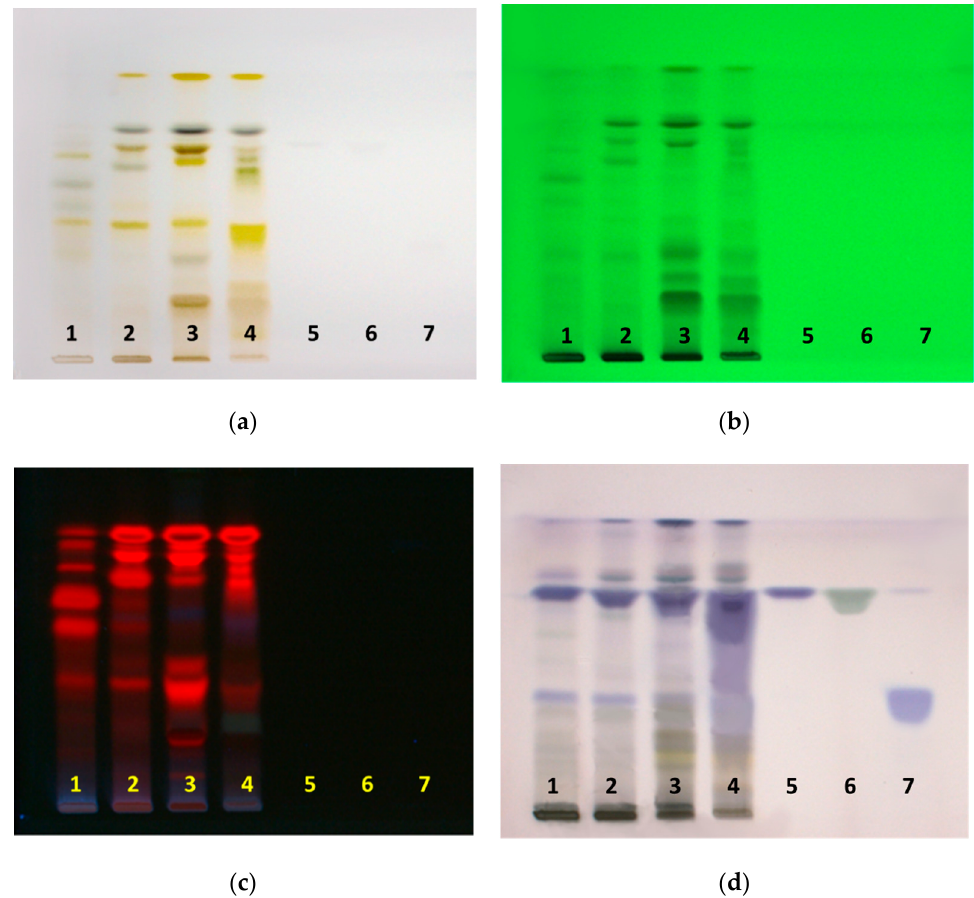
Figure 1. HPTLC fingerprints of olive leaf extracts and triterpenoid acids under ( a ) white light ( b ) 254 nm ( c ) 366 nm ( d ) after derivatization with anisaldehyde/sulfuric acid under white light. Track 1, methanol extract; track 2, ethanol extract; track 3, ethyl acetate extracts; track 4, ethyl acetate phase from the water: ethyl acetate extract; track 5 oleanolic acid; track 6, ursolic acid; track 7, maslinic acid.